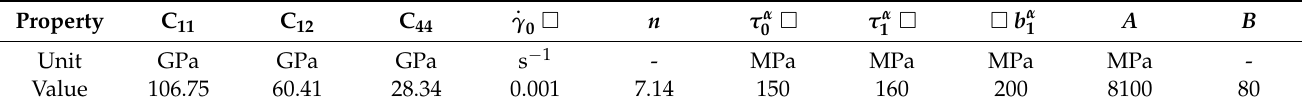
Table 1. Elastic constants and crystal plasticity parameters for aluminum alloy